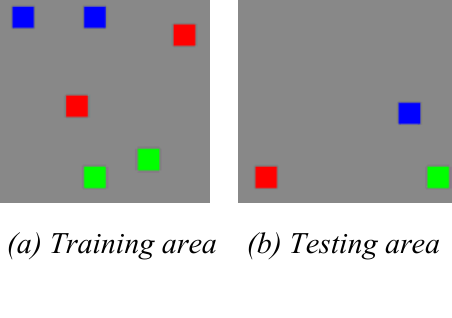
Figure 11. Sample data of San Francisco (Red denotes sea, green urban areas, blue vegetated